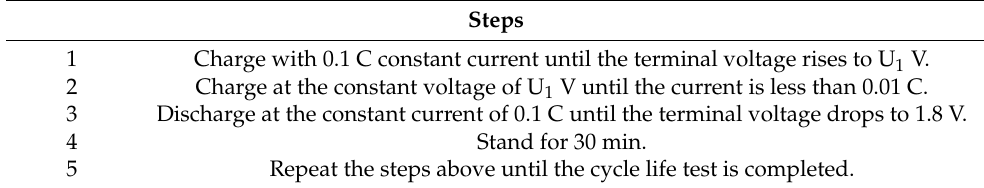
Figure 2. The capacity degradation trajectory under different working conditions. Figure 3. Charge – discharge voltage and current curve for one cycle.